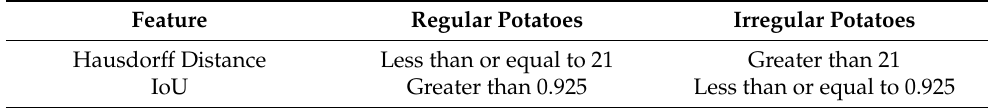
Table 5. Irregular potato identification